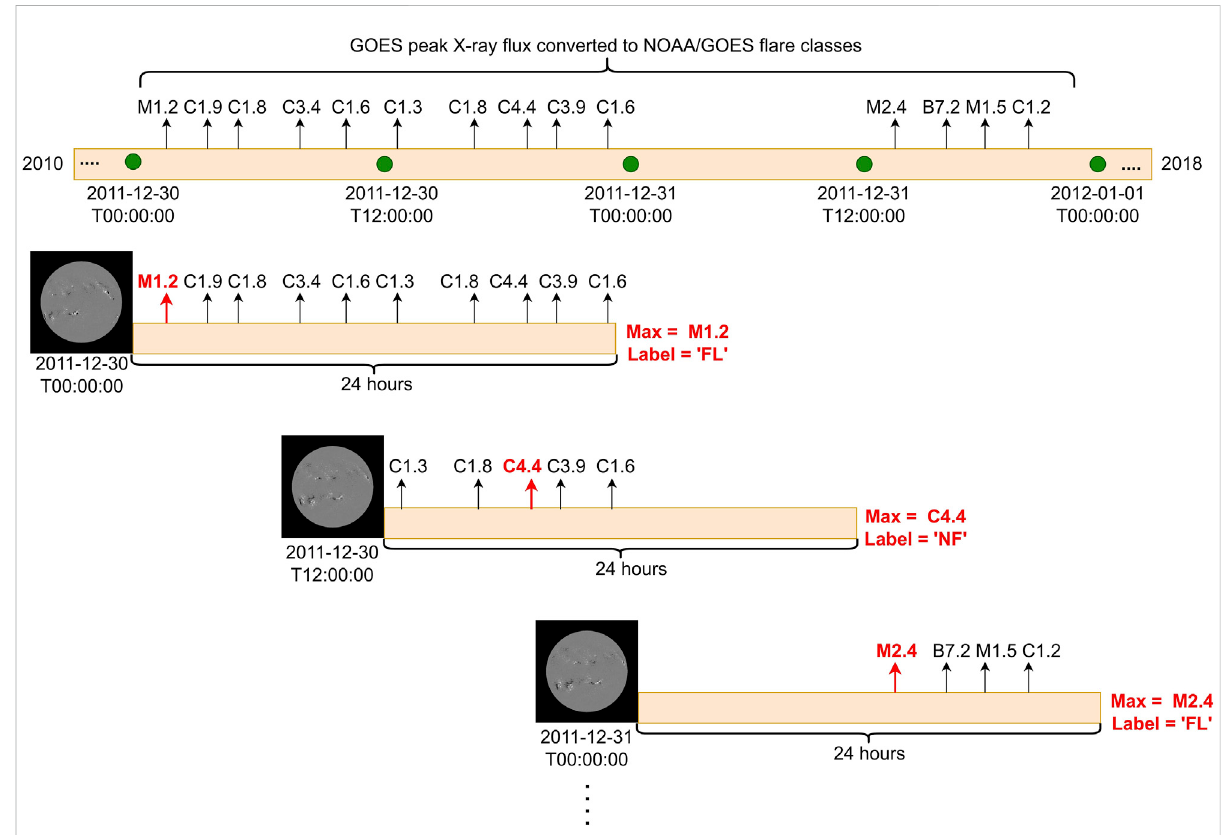
FIGURE 1 A timeline diagram to present the problem formulation of our deep learning-based full-disk fl are prediction model using bi-daily observations of full-disk line-of-sight magnetograms and prediction window of 24 h considered to label the magnetogram